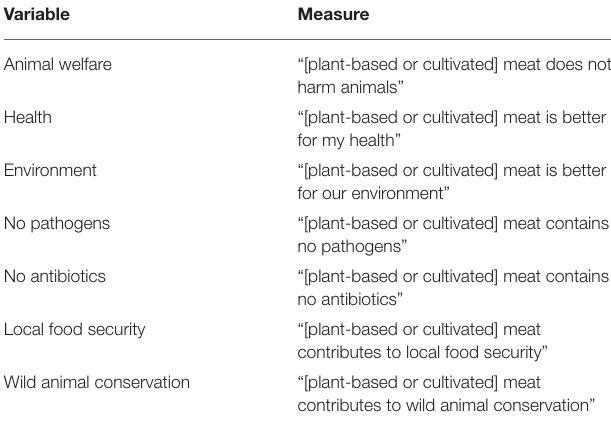
TABLE 2 | Measurement of purchasing